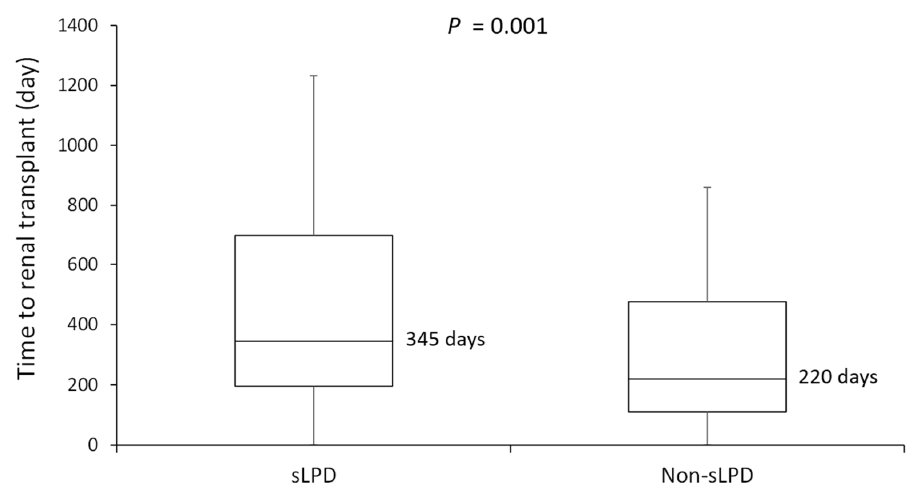
Figure 3. Median duration from the day of advanced CKD diagnosis to the day of kidney transplan- tation in the sLPD and non-sLPD groups. sLPD, ketoanalogue-supplemented low-protein diet. The mean follow-up duration after kidney transplantation was 6.7 years (standard deviation: 4.1 years) among the 245 patients. No significant difference between groups was found in terms of all-cause mortality, MACCE, infection-related hospitalization or death, newly diagnosed malignancy, new-onset diabetes mellitus, osteoporosis-related fracture, or allograft failure requiring dialysis (Table 2). Table 2. Follow-up outcomes of patients after receiving preemptive kidney transplantation, by pre- vious treatment sLPD.